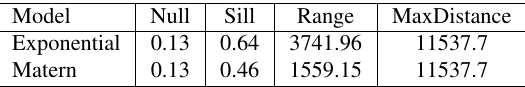
Table 9: Models of adjusted